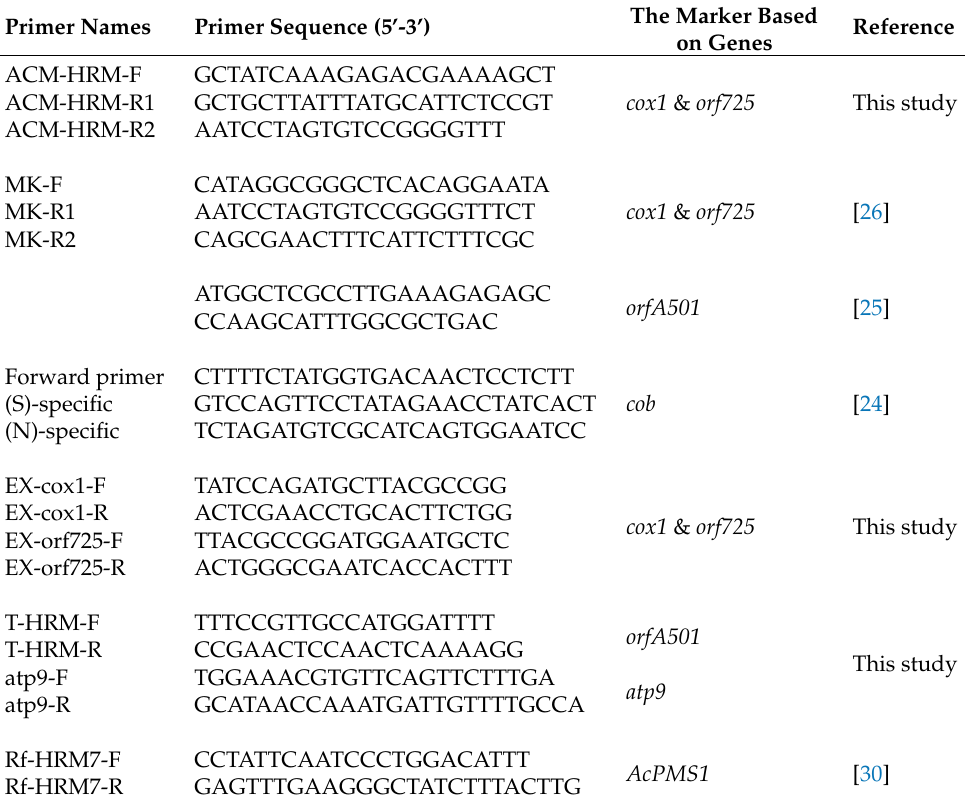
Table 5. PCR markers used for the determination of cytoplasm types and Ms locus in